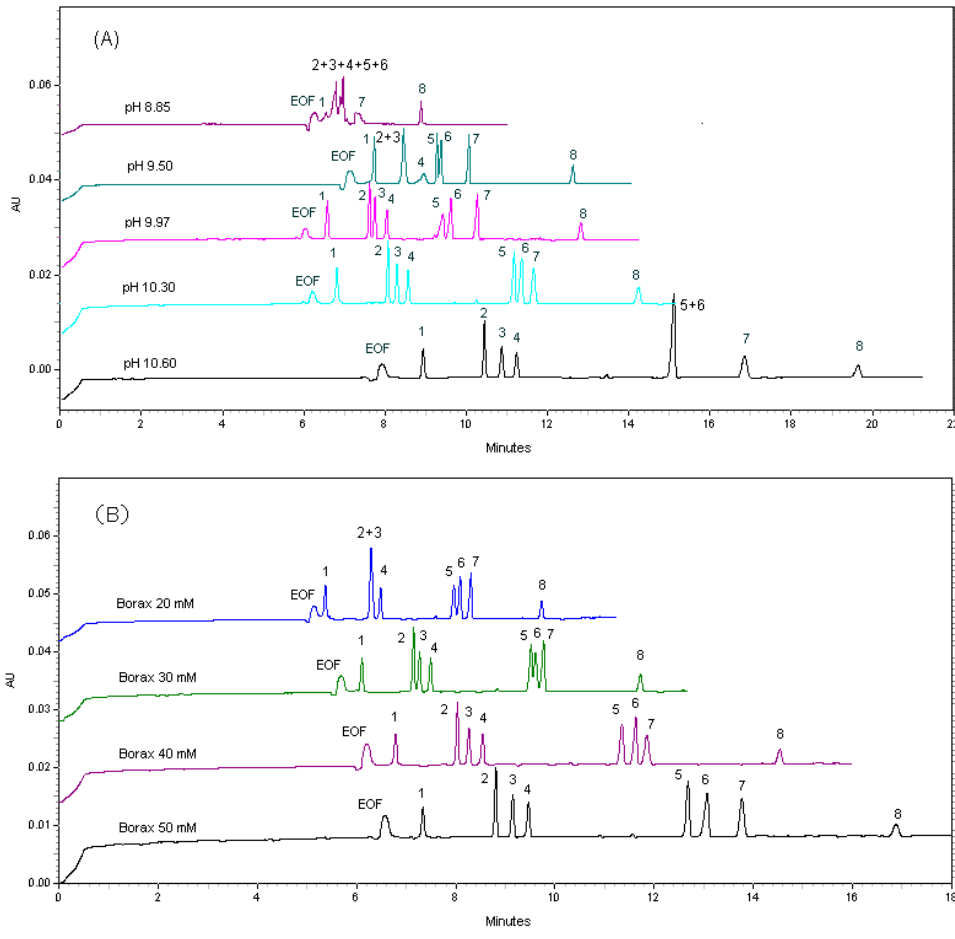
Figure 2. Effects of pH and buffer concentration on the migration time and separation of analytes. ( A ) 40 mM borax with 2 mM β -CD and 5% ( v / v ) methanol at different pH vaules; ( B ) different concentrations of borax with 2 mM β -CD and 5% ( v / v ) methanol at pH 10.30.